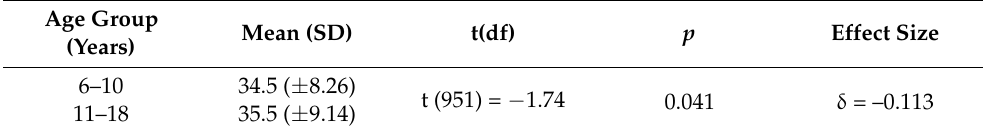
Table 2. Differences in state anxiety between age groups.